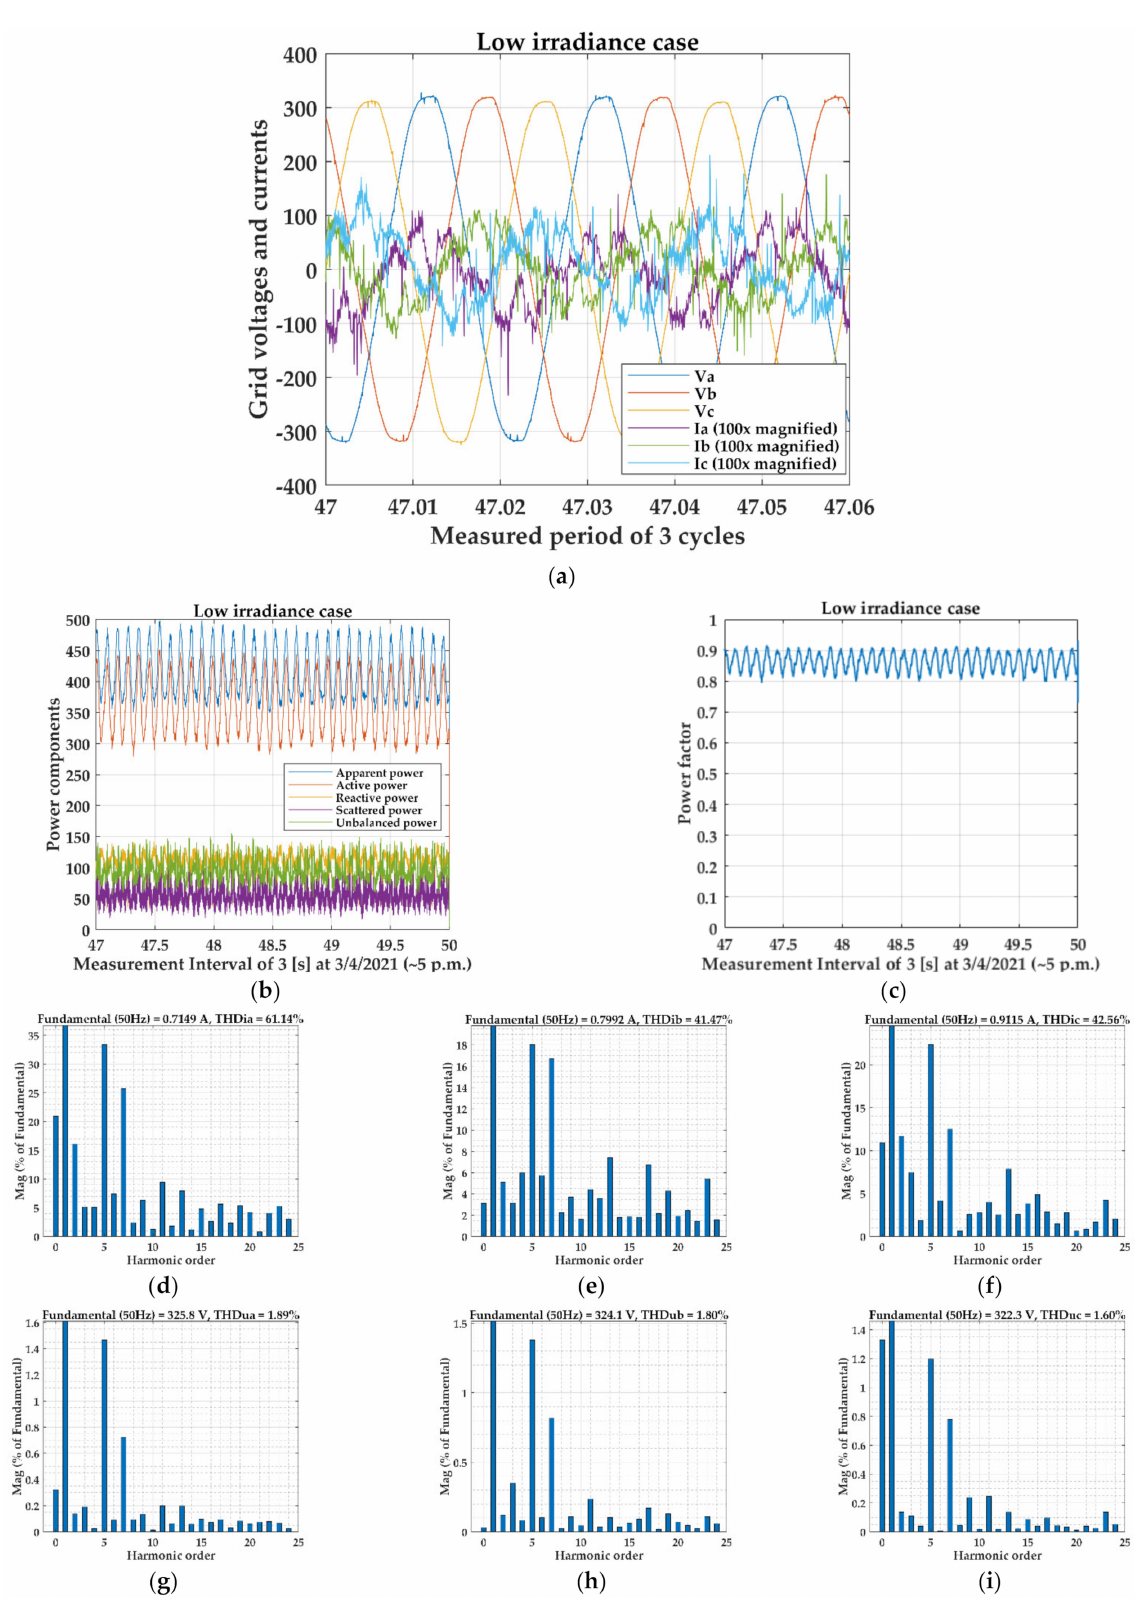
Figure 7. Experimental results for the low irradiance case: ( a ) Grid voltage and current waveforms; ( b ) power components according to CPC theory; ( c ) power factor; ( d – f ) harmonic spectra and THD I factors of inverter currents; ( g – i ) harmonic spectra and THD U factors of grid